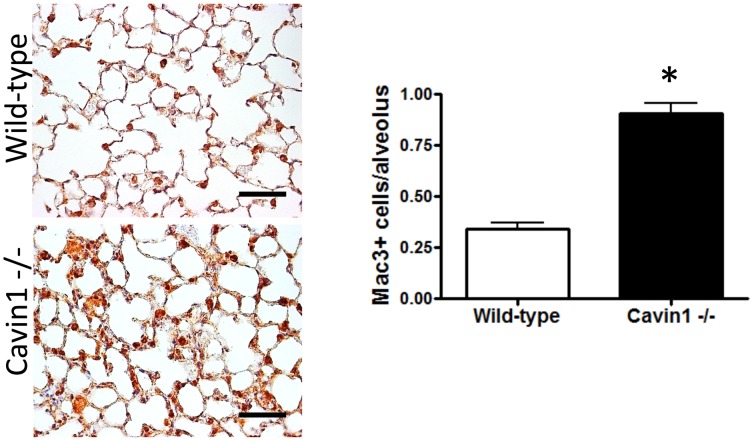
Macrophages are increased in the lungs of Cavin1−/− mice.(Left) Immunohistostaining for Mac3 in lungs of wild-type and Cavin1−/− mice. (Right) Morphometric data showing numbers of Mac3+ cells/alveolus in wild-type and Cavin1−/− mice (300 alveoli/per mouse, 5 mice per group, p<0.001).